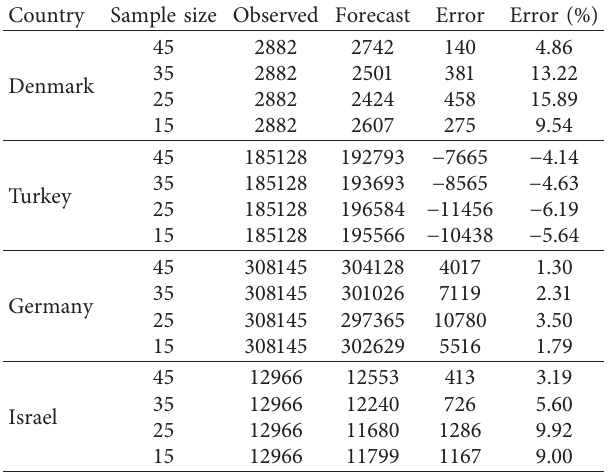
Table 5: The forecast error of the best-fit models for year 2016. Country Sample size Observed Forecast